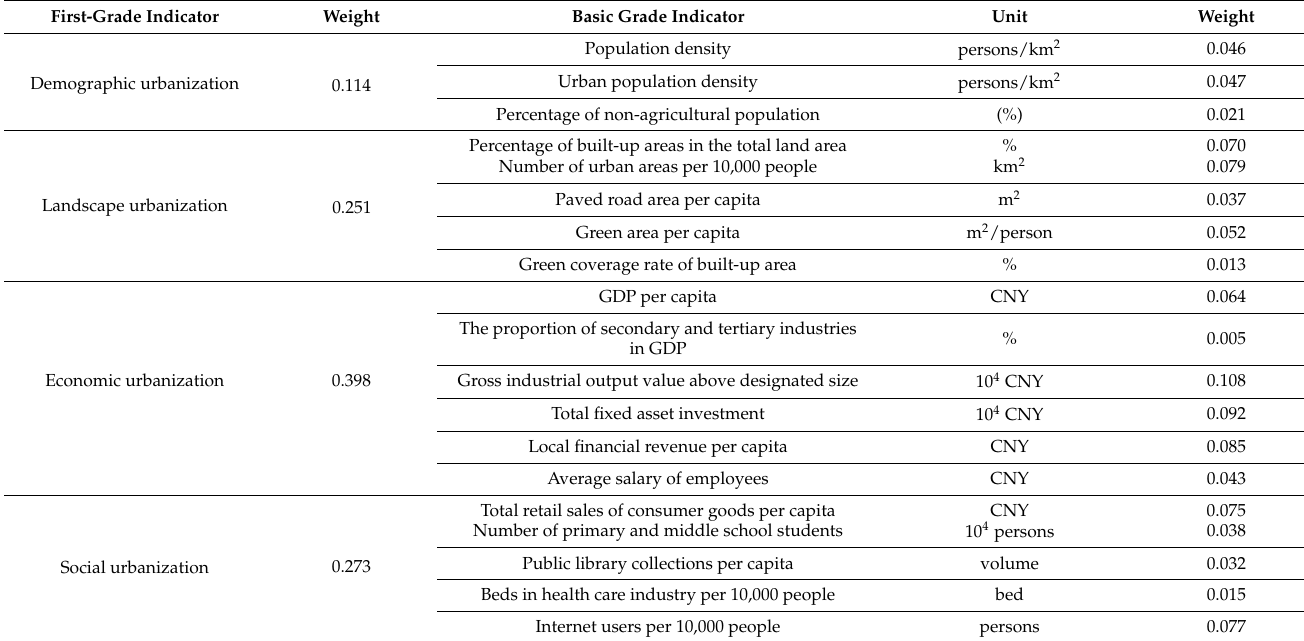
Table 1. Comprehensive evaluation index system for urbanization in the Yellow River Basin,